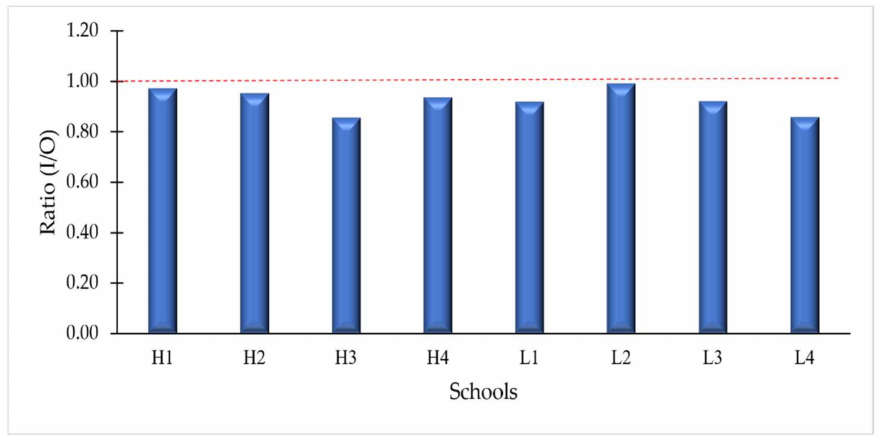
Figure 3. Indoor to outdoor (I/O) ratios of PAHs concentration in each